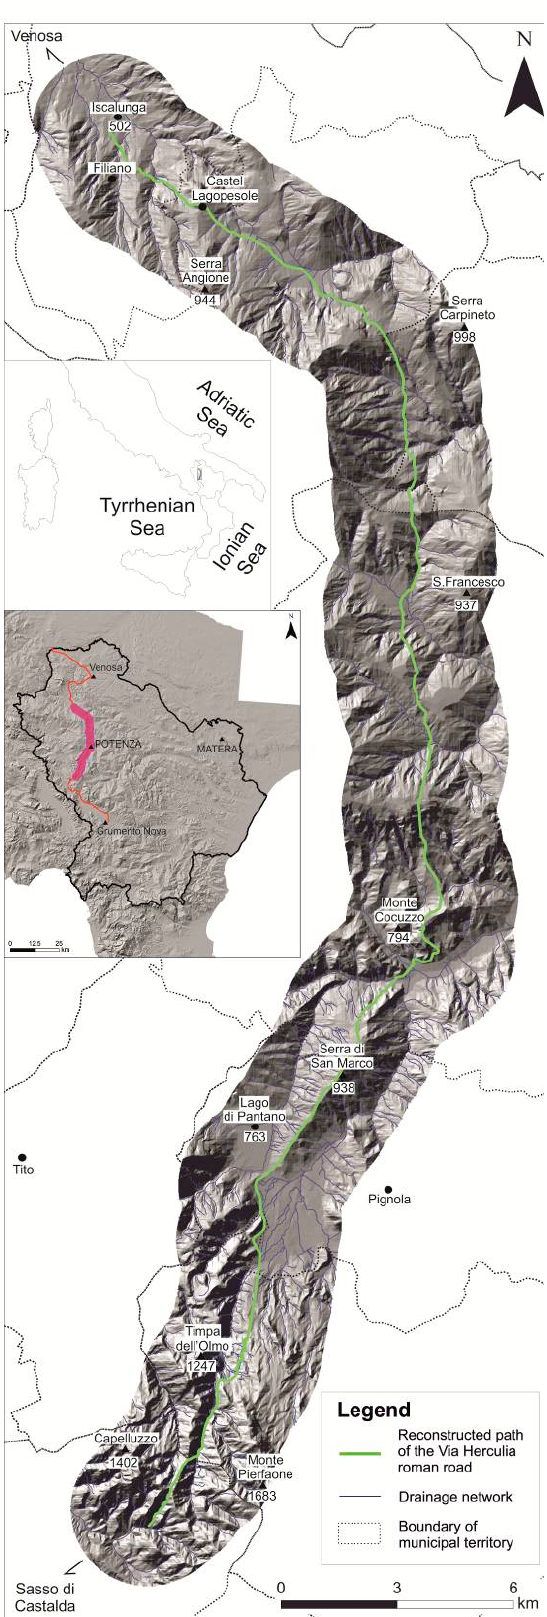
Figure 1. Hillshade of the study area with the location of the reconstructed path of the Roman road in the central sector of the Basilicata region. In the inset: Regional geographical framework of the study area.